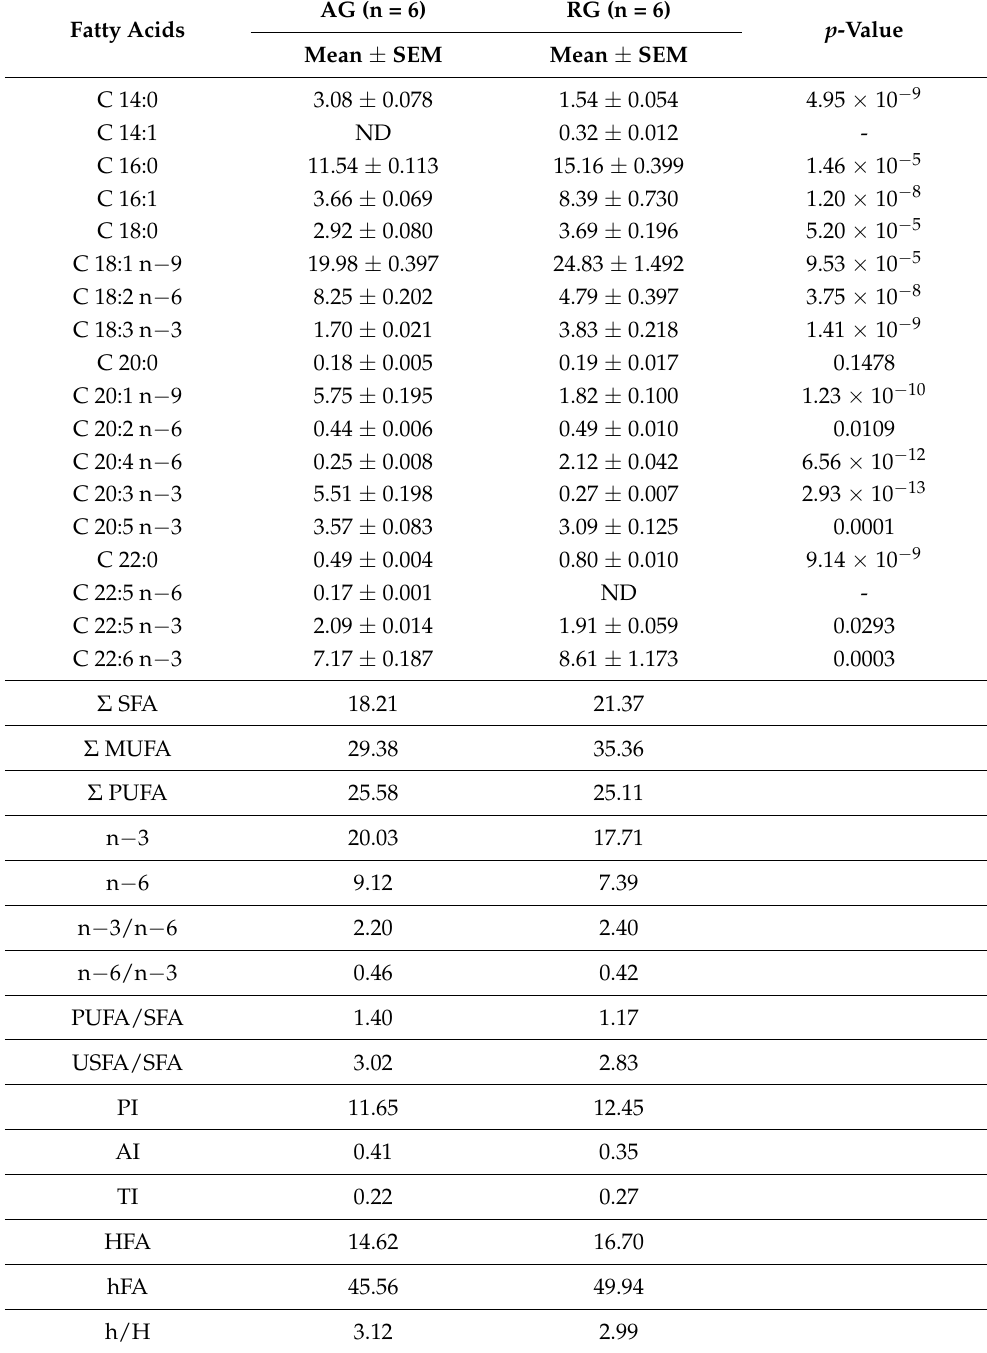
Table 6. Fatty acids profile (g/100 g total FAME) and sanogenic indices of European catfish fillets. Fatty